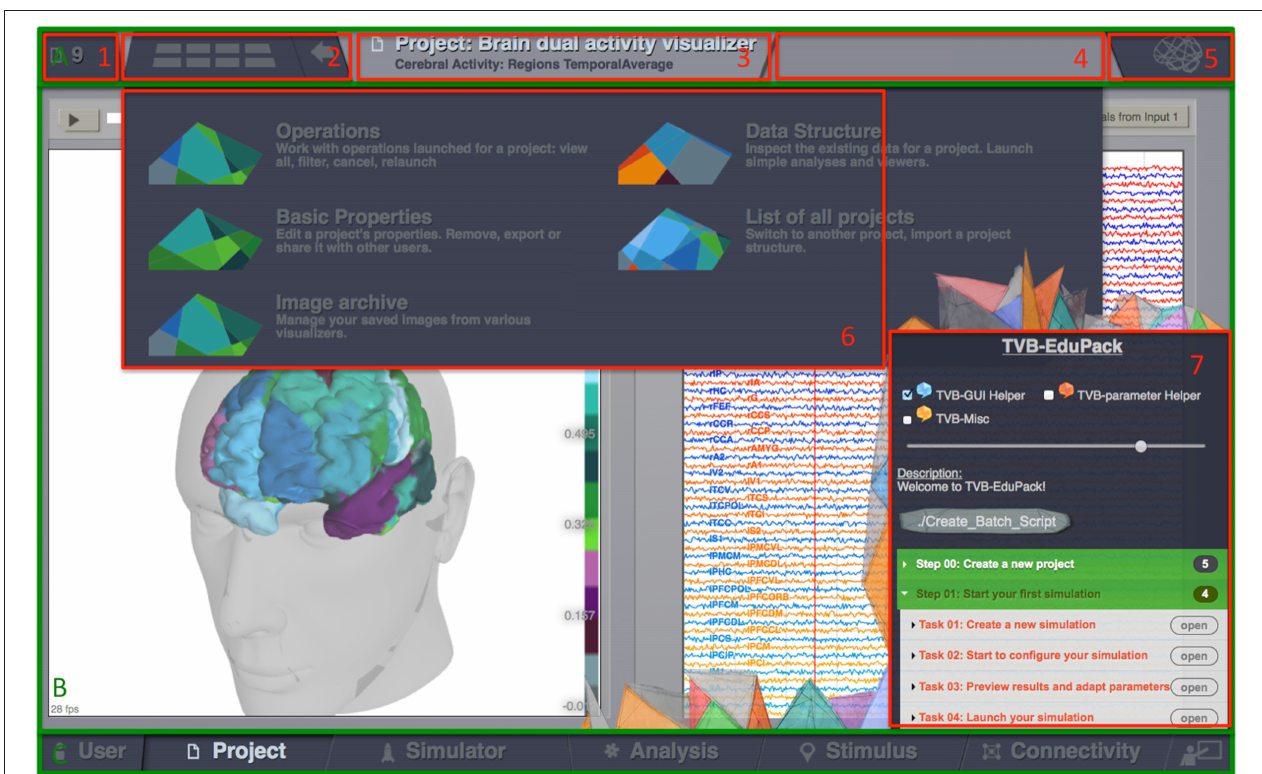
FIGURE 1 | The Virtual Brain GUI is divided into three main areas: header menu (A), main area (B), and footer menu (C). The header menu shows the identifier of the current project (1), a button (2) a drop down menu (6) with functionalities of the active tab (3). The upper right corner contains an information panel about currently running operations (4) and another drop-down menu (5) with options for the current tab. The main area shows the currently active TVB interface-tab and, if active, the Edu-Pack menu (7). The footer (C) allows to switch between the different interface tabs: USER , for managing User accounts and general settings, PROJECT , for managing and exchanging projects and associated input/output data, SIMULATOR , to configure, launch, and monitor simulations, ANALYZE , where simulation results can be analyzed, STIMULUS , where users can create model stimulation patterns for simulations and CONNECTIVITY , for visually editing local and large-scale